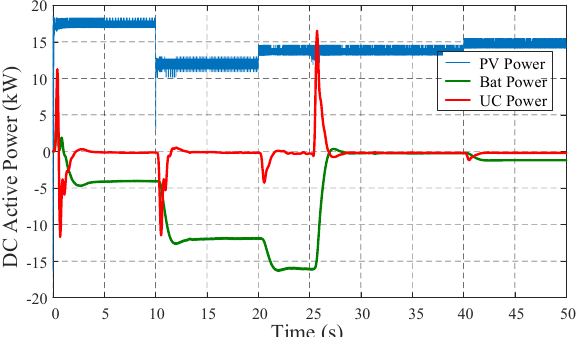
Figure 17. DC bus voltage.